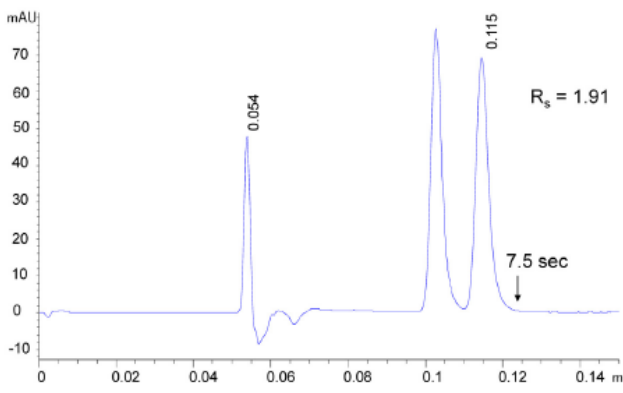
Figure 4. Fast SFC separation of trans -stilbene oxide enantiomers on a 50 × 3.0 mm (L × I.D.) column packed with 1.6 µ m FPPs functionalized with amylose, F v = 4.65 mL/min, mobile phase: CO 2 /methanol 70%:30% ( v / v ), 40 ◦ C. Reproduced with permission from ref.